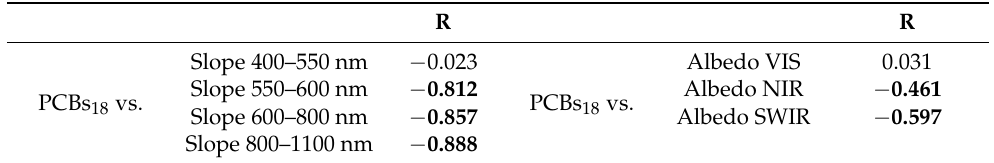
Table 4. Correlation coefficients (r) among PCBs 18 contents, slopes, and albedo in the different spectral regions.